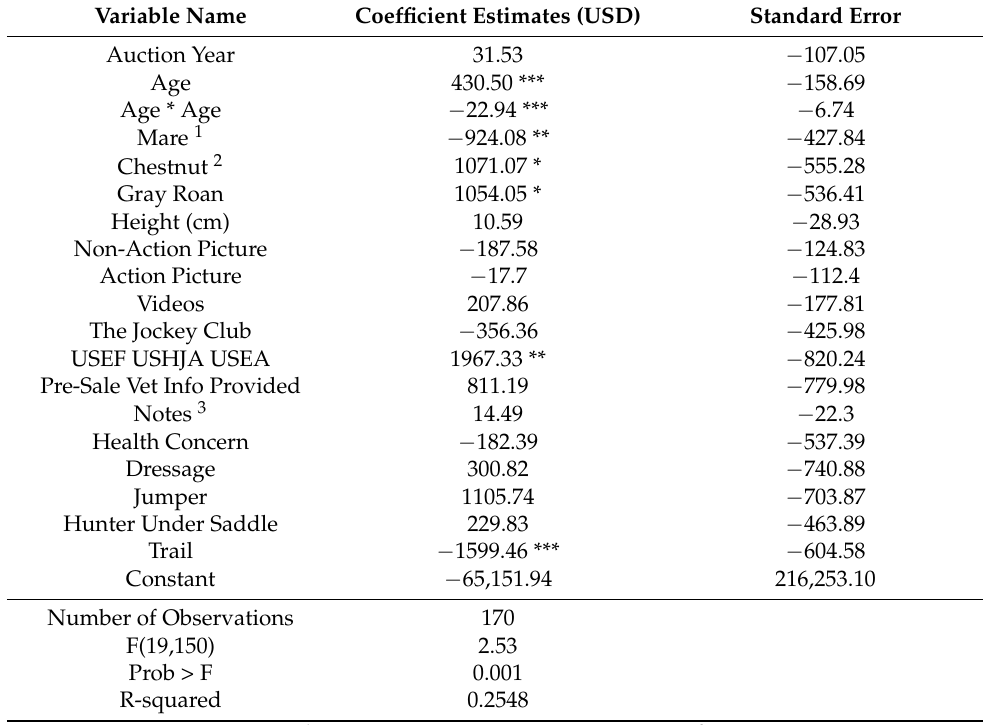
Table 2. Hedonic Modeling Regression Results for Thoroughbred’s Sold in Online Auctions